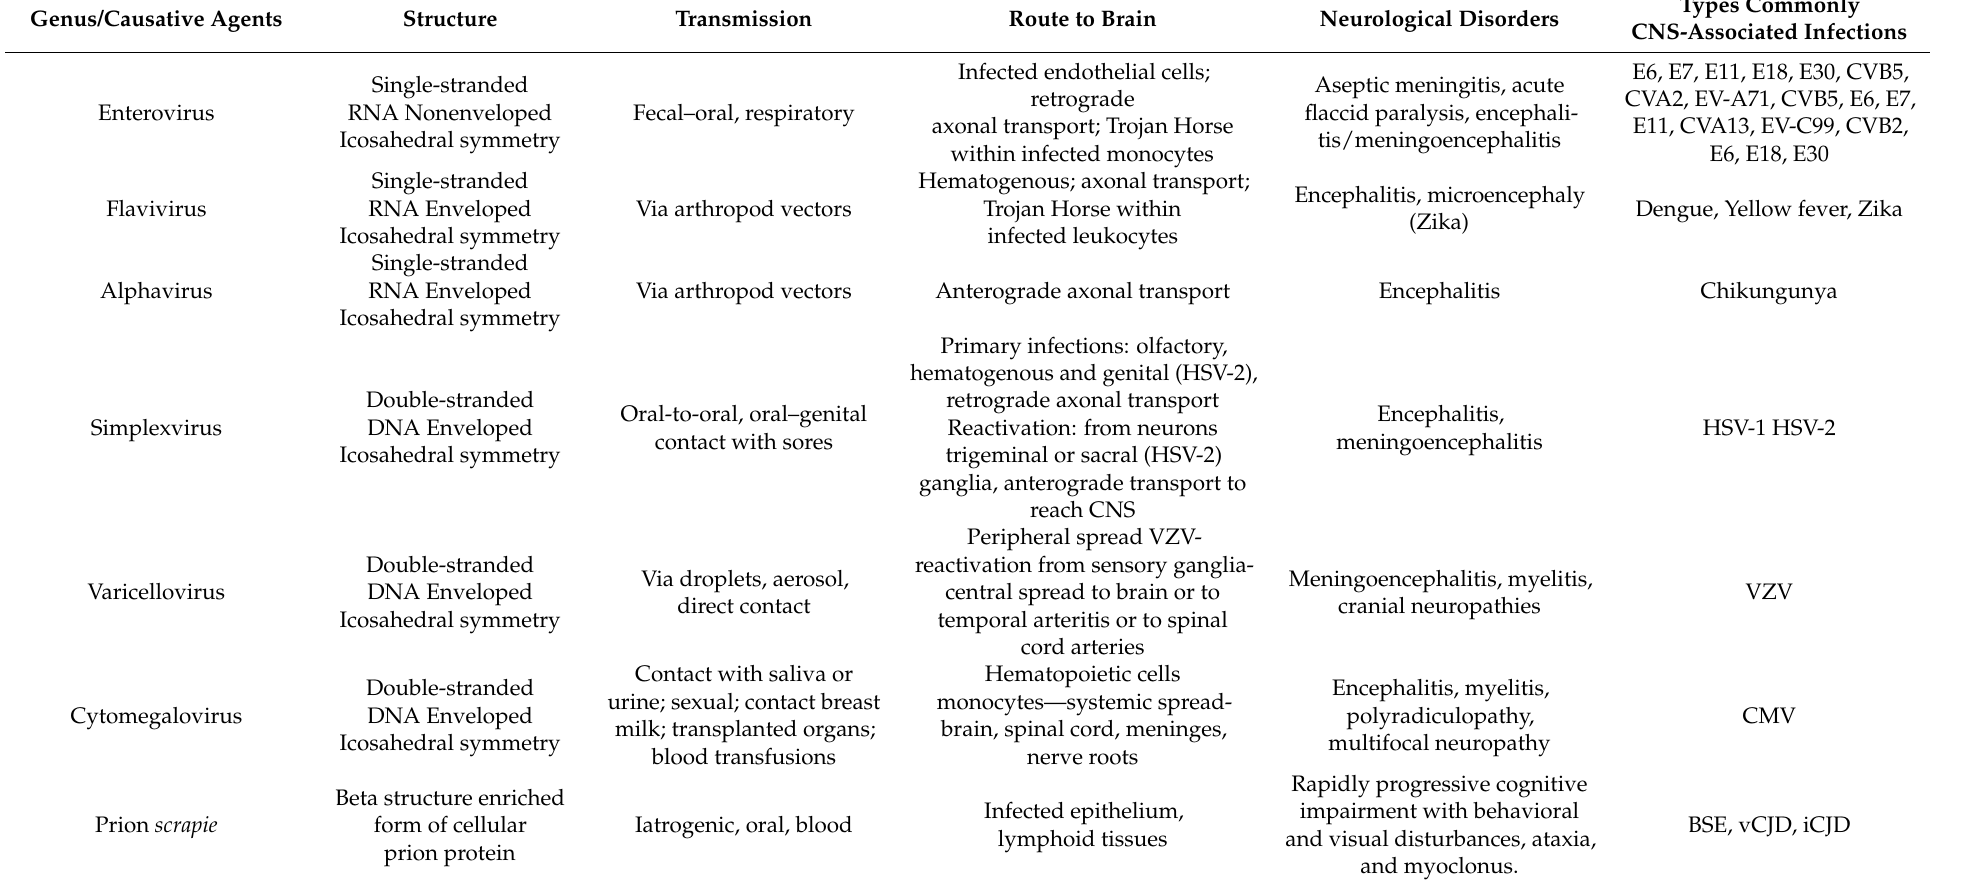
Table 1. Viral and prion infections in CNS-associated infections in